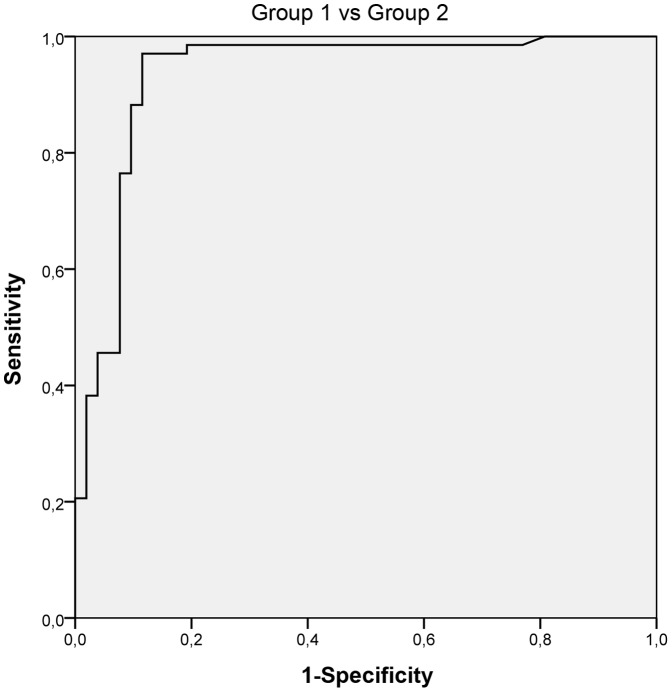
ROC curve to determine the new CSF neopterin cut-off.The samples were classified into two groups according to the condition that they presented either bacterial/viral central infection (n = 68) or peripheral infection (n = 52). The area under the curve was 0.934 (range: 0.883–0.985) with 61 nmol/l as the new cut-off. The sensitivity was 91.3%, and the specificity was 88.5%.